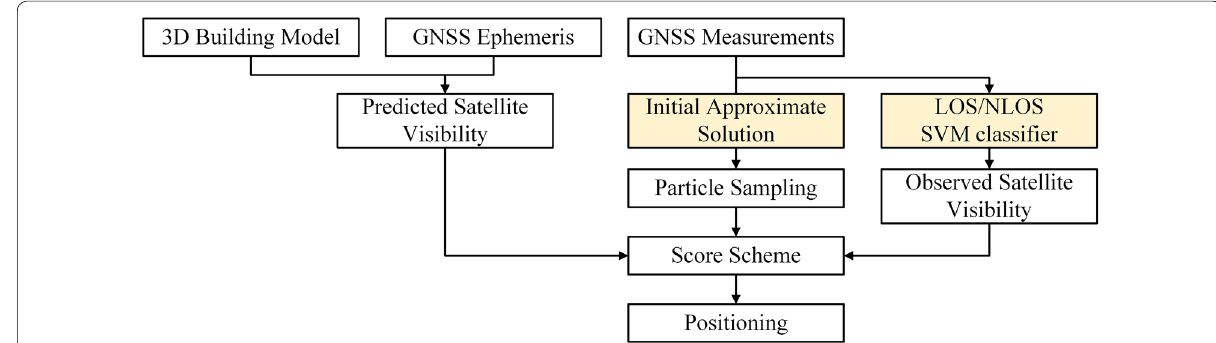
Fig. 1 Flowchart of SDM with SVM classification and R‑WLSb